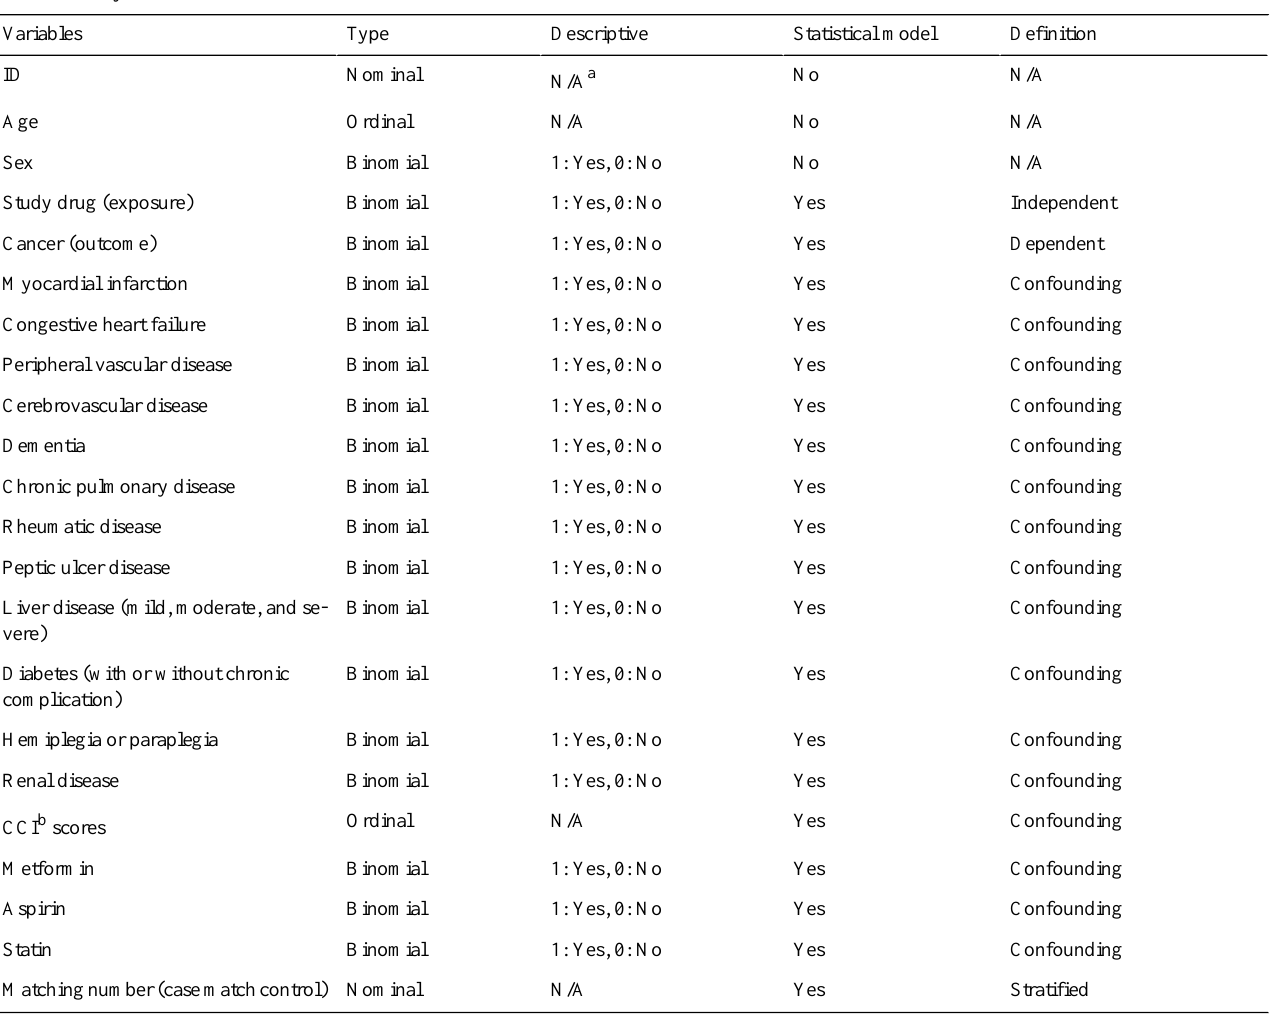
Table 1. Study variables.